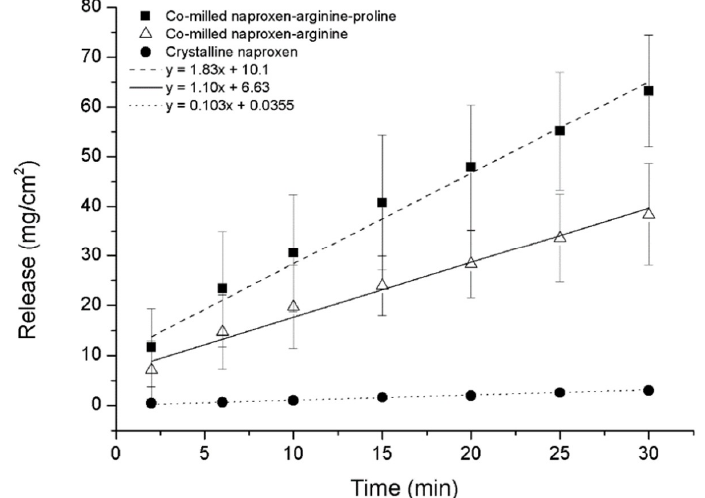
Figure 9. Improved dissolution rate by adding a high-water solubility amino acid in ternary mixtures